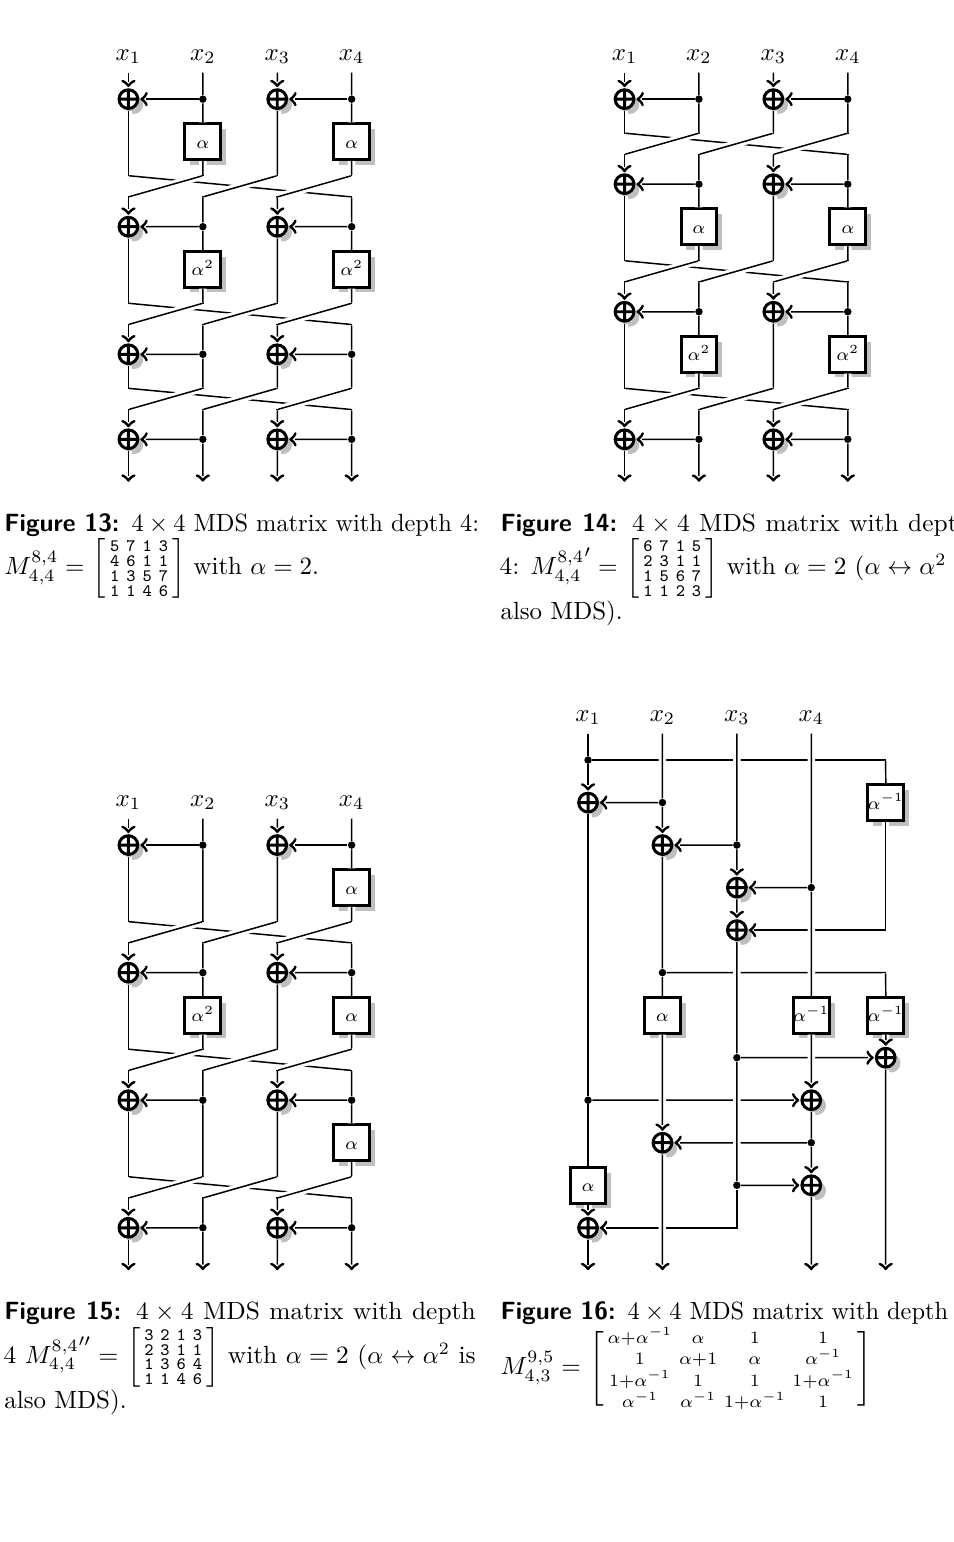
Figure 15: 4 × 4 MDS matrix with depth (cid:20) 3 2 1 3 ′′ 2 3 1 1 4 M 8 , 4 = 4 , 4 1 3 6 4